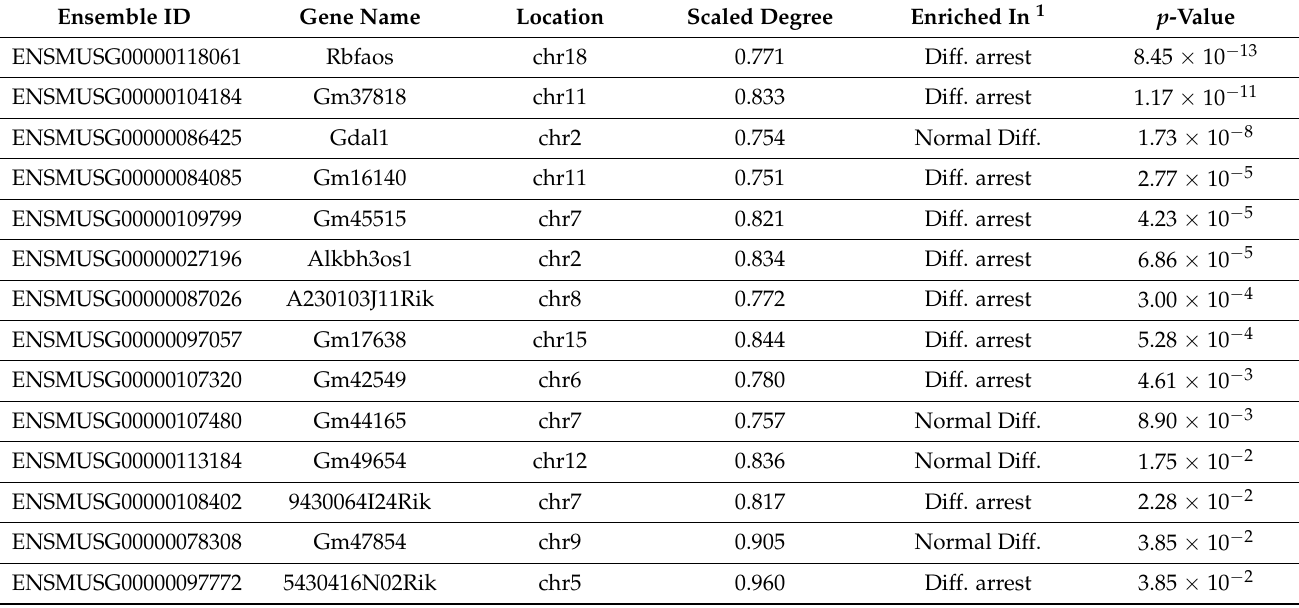
Table 1. Information of 14 important lncRNA genes in the context of CSH3 cells